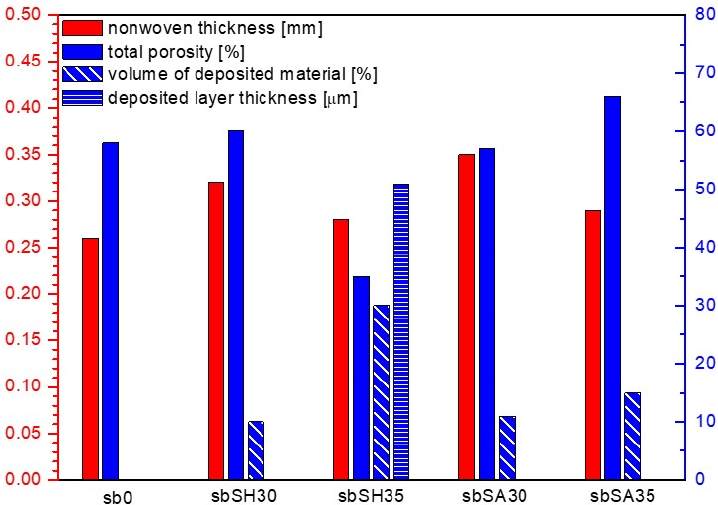
Figure 8. Structural parameters of unmodified and modified spun ‐ bonded PLA nonwoven